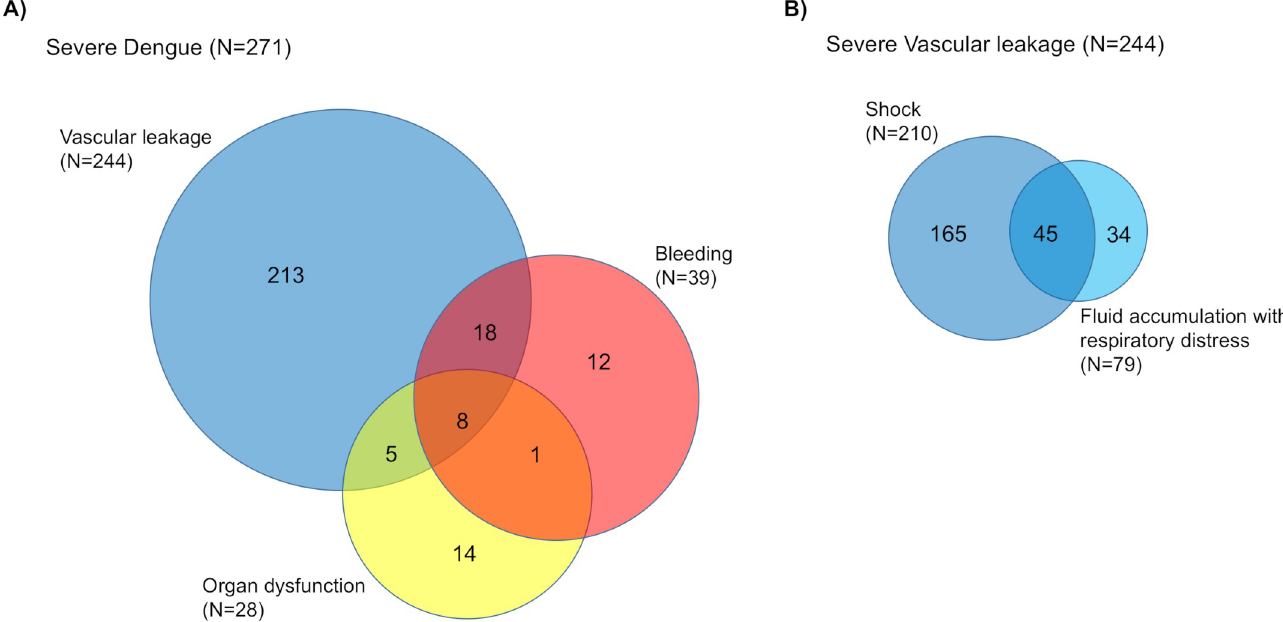
Fig 1. Overlap between severe vascular leakage, severe bleeding and severe organ dysfunction in 271 patients with severe dengue. (A) Overlap between severe plasma leakage, severe bleeding and severe organ dysfunction; (B) Overlap of shock and fluid accumulation with respiratory distress in 244 patients with severe vascular